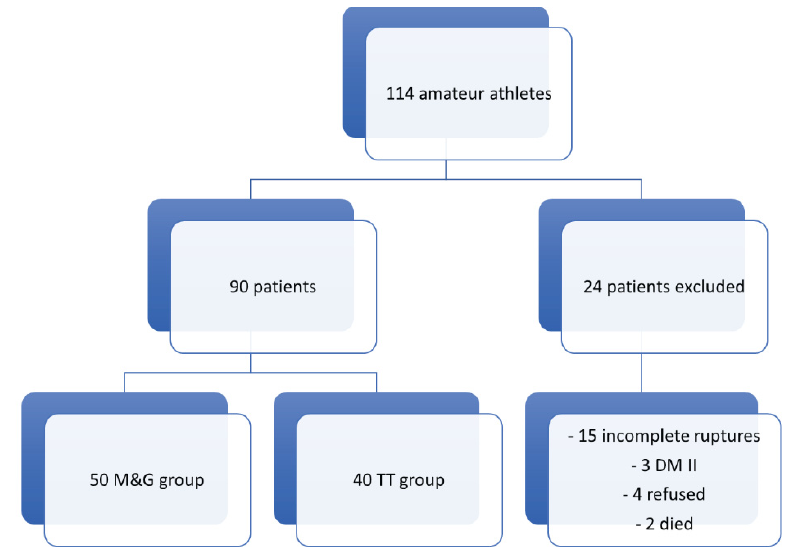
Figure 1. Flowchart of patient selection. DM II: diabetes mellitus type II; M&G: Ma and Griffith technique; TT: Tenolig technique.